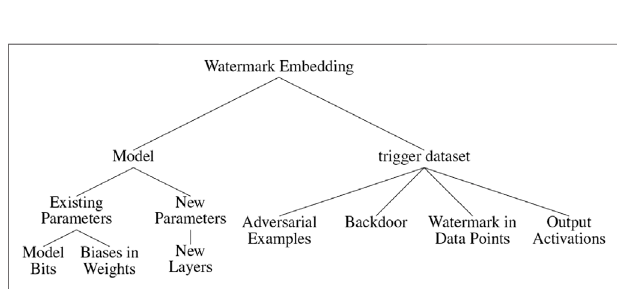
FIGURE 5 | Taxonomy-tree depicting the methods that can be used to insert a watermark into an ML model.